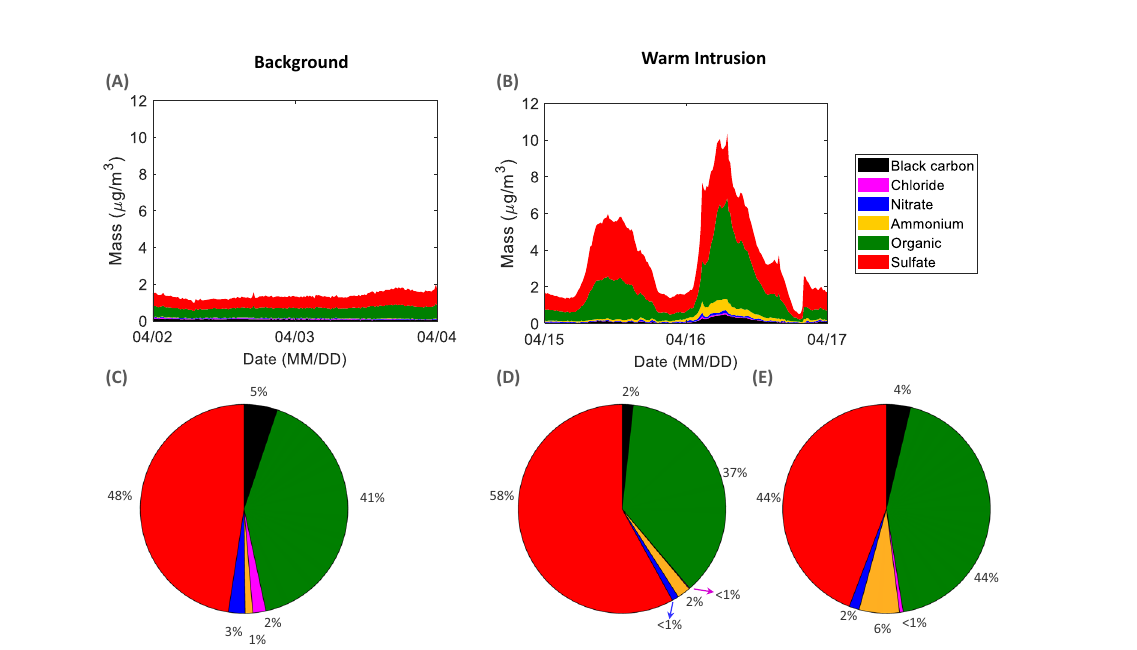
Fig. 4 | Central Arctic aerosol mass composition. Aerosol mass composition (averagedover15min)during( A )thebackgroundperiodand( B )thewarmair-mass intrusion event. Pie charts show the percentage contribution of each of the che- mical components to the total PM 1 (particulate matter with diameter smaller than